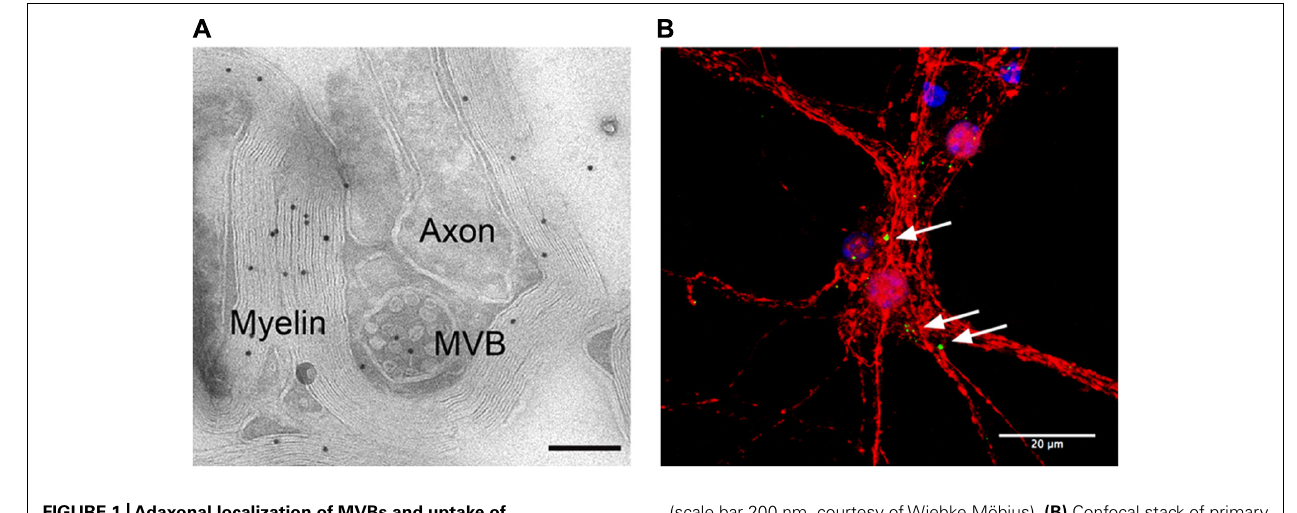
(scale bar 200 nm, courtesy ofWiebke Möbius). (B) Confocal stack of primary cortical neurons (red) that internalized exosomes, labeled with PLP-EGFP and SIRT2-EYFP (green). Nuclei are blue, scale bar 20 μ